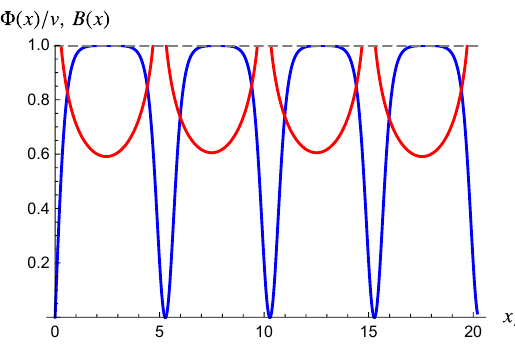
Figure 2 . The field profile of a vortex lattice in a 1D slice. The blue line is the profile of the radial mode | Φ( x ) | , which has a characteristic extent of ξ , while the red line is the profile of the magnetic field, whose periodicity is the lattice spacing a L . Here we take δ/ξ = 10 and a L /ξ = 5